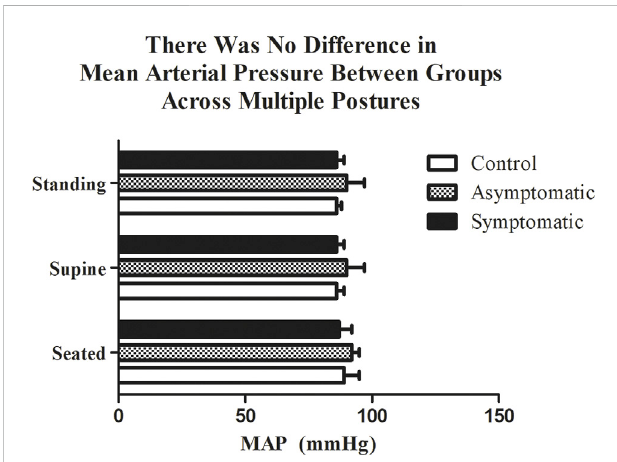
There was no difference in mean arterial pressure (MAP) between groups while standing, seated, or lying. n = 9/group. Data analyzed by a Two-Way Repeated Measures ANOVA with a Bonferroni post-hoc. Data are presented as mean ± SE; MAP = mean arterial pressure. Signi fi cance was set to p < 0.05.